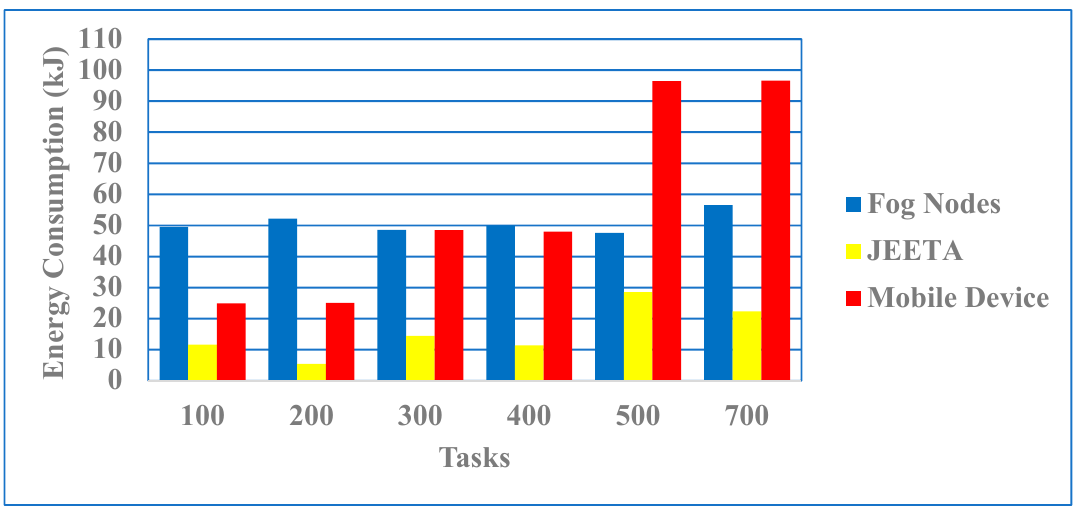
Figure 5. Workflow application: Number of tasks completed within a given deadline. Figure 6. Workflow application number of tasks completed within a given deadline. 5.3. Total Energy Consumption in Scenario